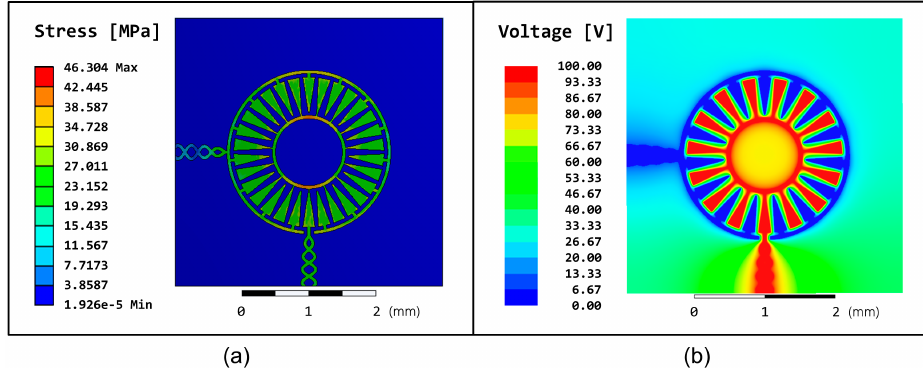
Figure 6. ( a ) Static structural ANSYS simulation results of von Mises equivalent stress in a single electrowetting cell which has been wrapped around a cylinder of radius equal to 30 mm. Maximum stress is observed in the copper electrodes, but at levels well below the fracture point of copper; ( b ) ANSYS Maxwell electrostatic simulation of region on top of Parylene C and CYTOP insulators, where one set of interdigitated electrodes is ground, and the other set has had 100 V applied. Table 1. Values used in static structural ANSYS simulation to determine von Mises equivalent stress.